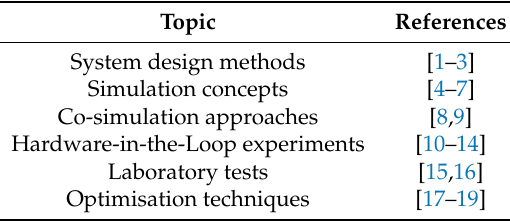
Table 1. Topics and included papers of the Special